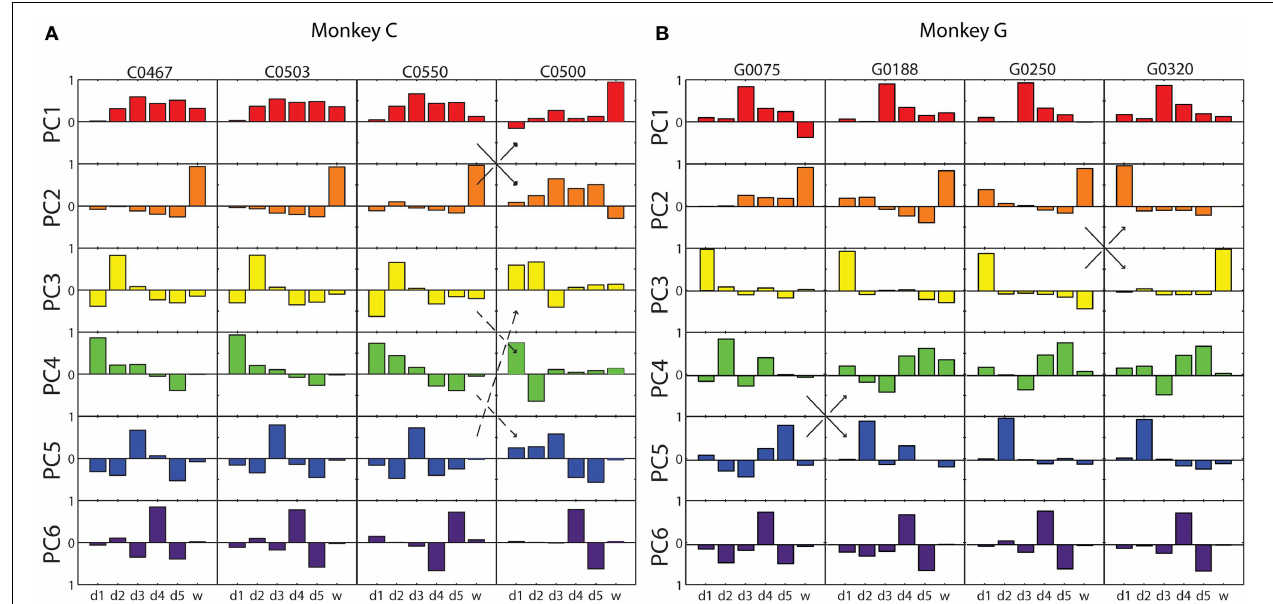
each of the original six DoF axes, from d1 through w. Solid arrows indicate instances in which two similar eigenvectors swapped rank order reflecting that one accounted for somewhat more variance in one session, whereas the other accounted for more variance in the other session. Dashed arrows indicate an instance in which the composition of three eigenvectors changed between two